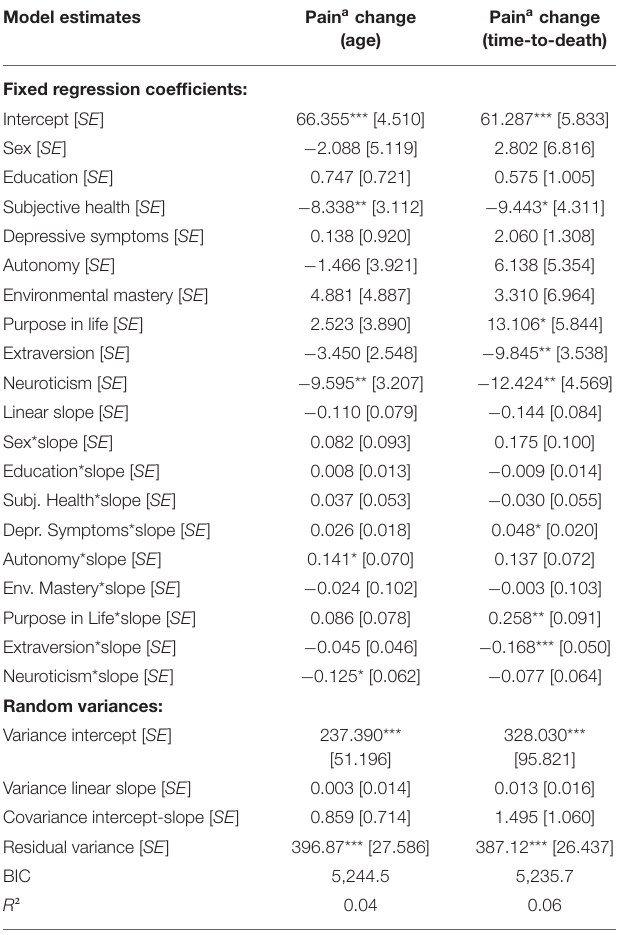
TABLE 3 | Predictors of changes in pain over age and over time-to-death. Model